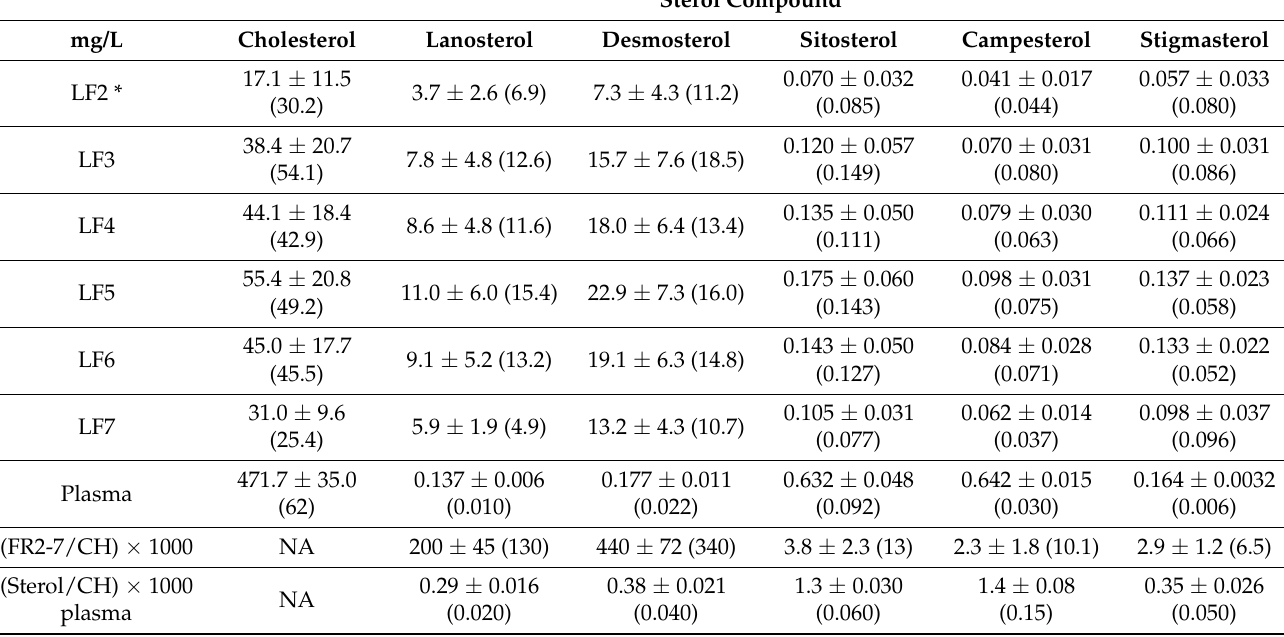
Table 3. Concentration of the identified free sterols in plasma membrane microdomain fractions LF2-LF7 and plasma. Mean ratios of non-cholesterol sterol to CH in cell membrane microdomains and plasma. Sterol